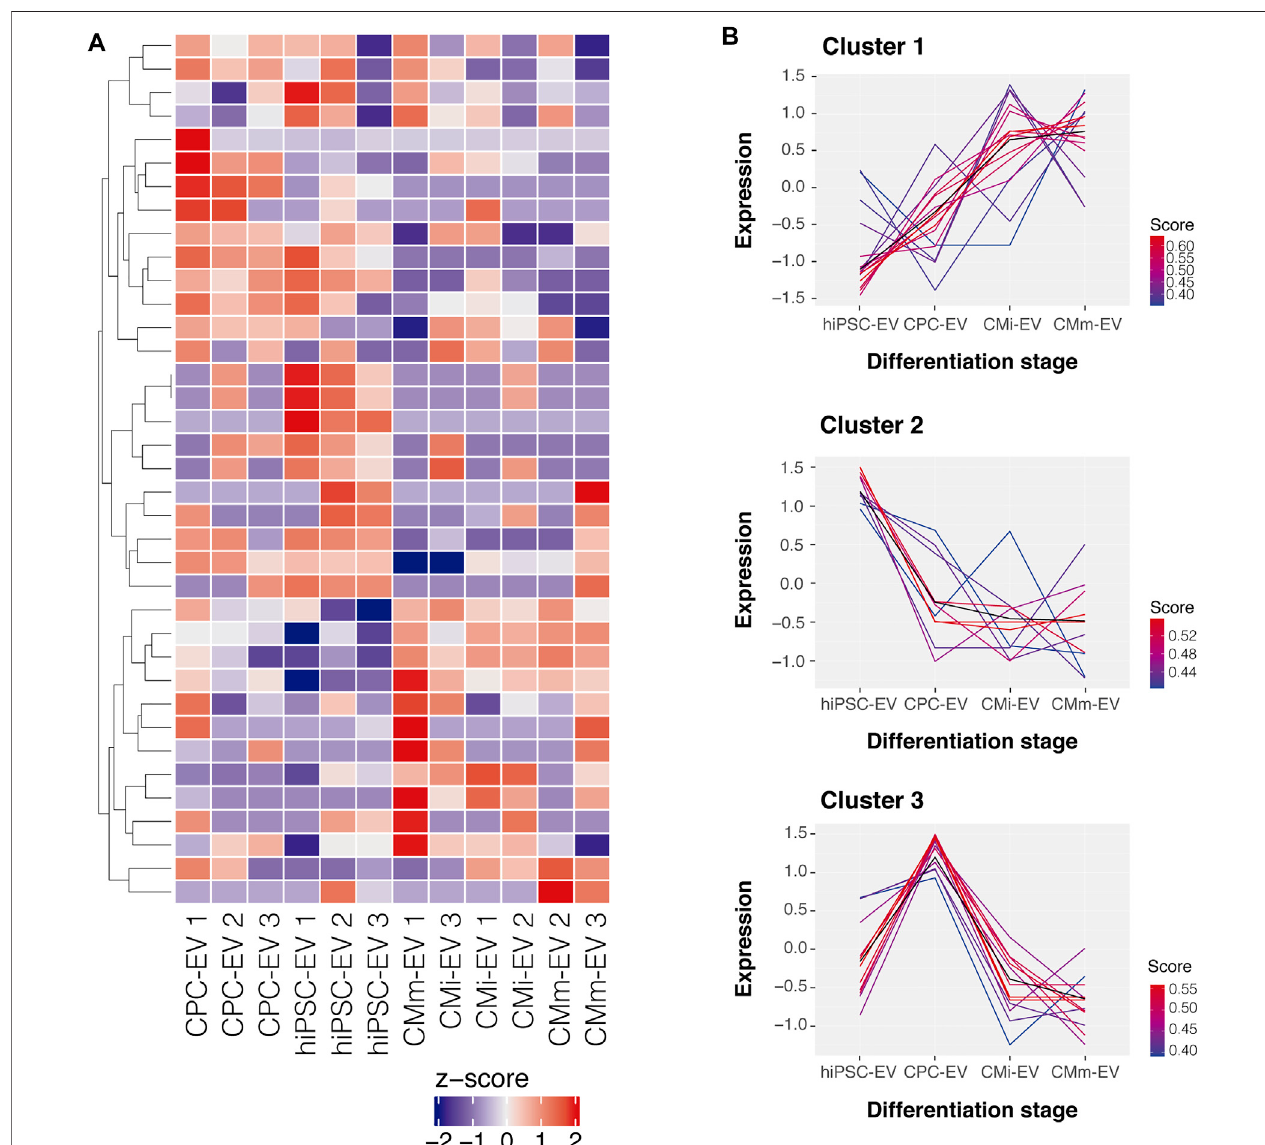
FIGURE 2 | Global piRNA expression pro fi les during hiPSC-CM differentiation. (A) Heatmap representation of the global piRNA expression pro fi les after fi ltering and normalization, in three biological replicates of hiPSC-EV, CPC-EV, CMi-EV and CMm-EV, with a minimum count of 5 reads in at least one EV population. Dendrograms are based on complete-linkage hierarchical clustering and Euclidean distances. (B) Fuzzy plots representing the dynamic expression of 3 piRNA clusters found in EV during hiPSC-CM differentiation and maturation, obtained by soft-clustering.